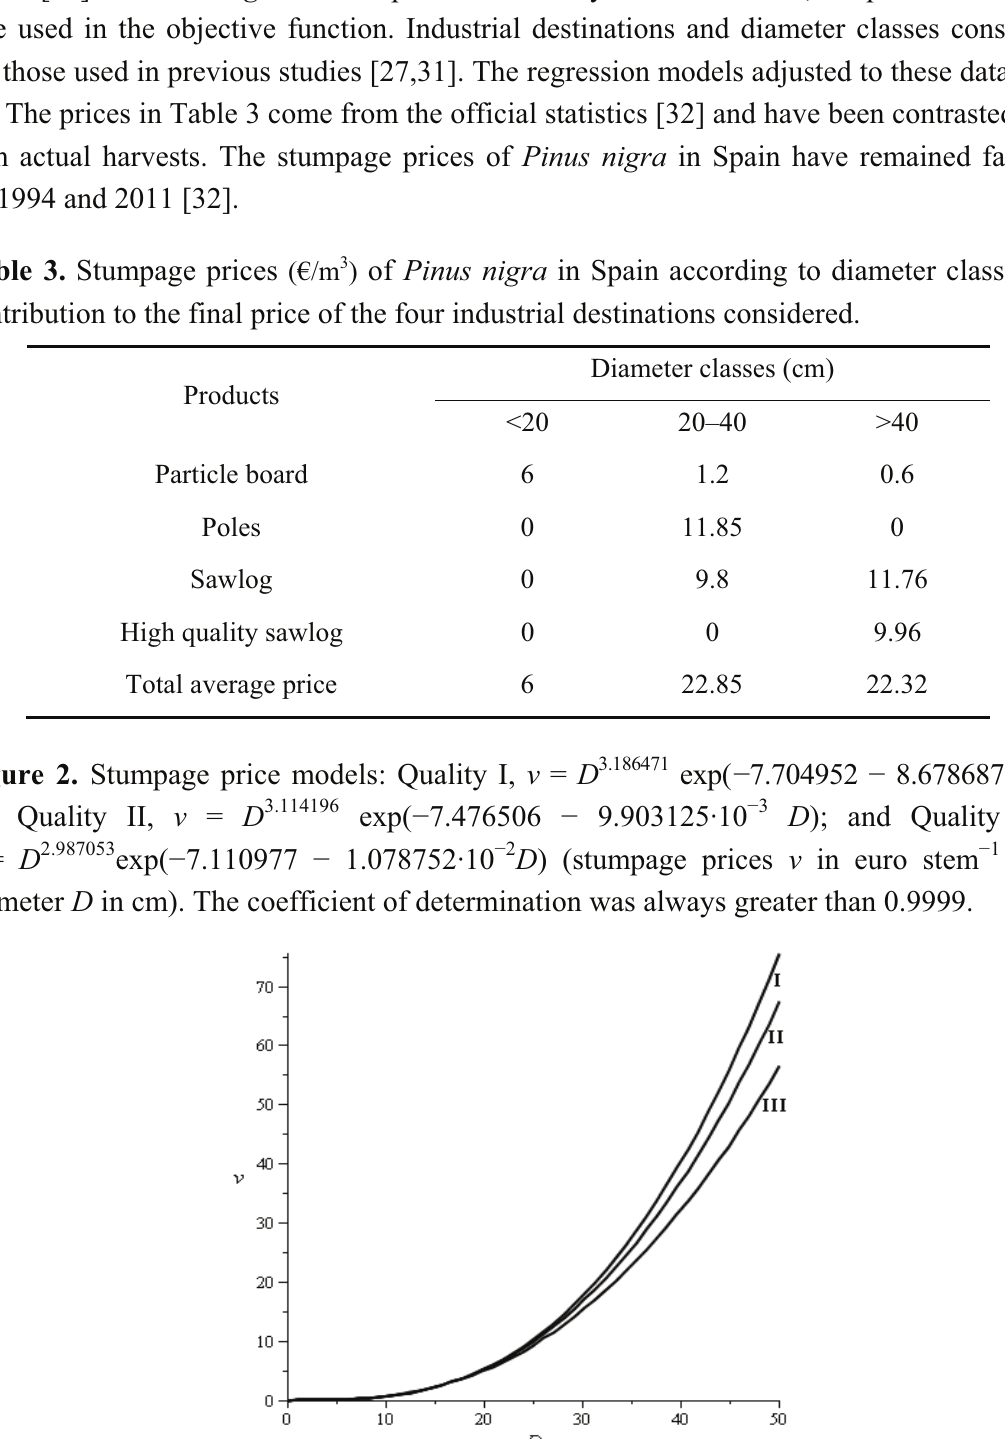
Table 3. Stumpage prices (€/m 3 ) of Pinus nigra in Spain according to diameter class and contribution to the final price of the four industrial destinations considered.